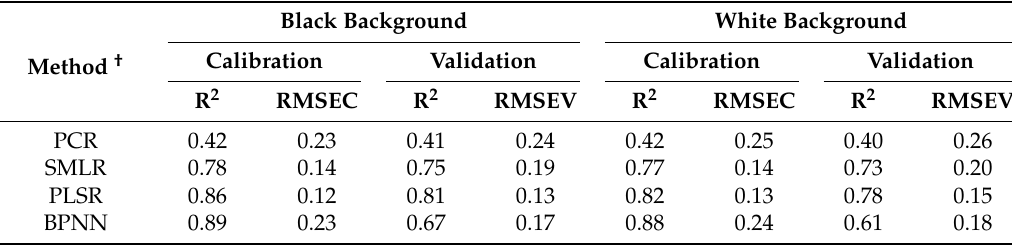
Table 2. Modelling results using four chemometric methods with two spectral datasets as measured by black or white